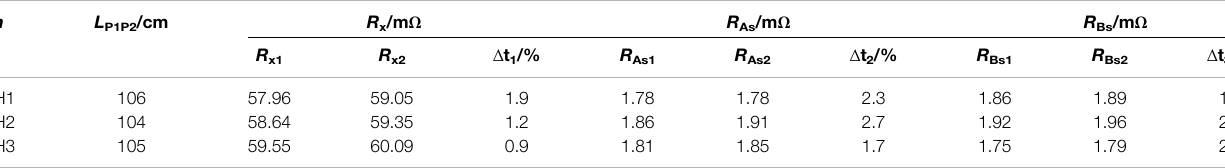
TABLE 4 | Measured resistance in the high-temperature withstand